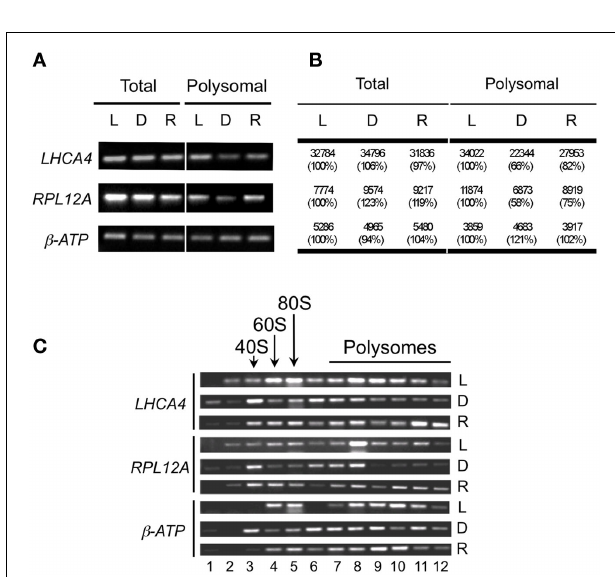
FIGURE 4 | Comparison of changes in mRNA abundance in the transcriptome and translatome. Venn diagrams indicate the number of genes in the total and immunopurified polysomal mRNAs that displayed a significant increase or decrease in abundance following the shift to early darkness or re-illumination. mRNAs analyzed included